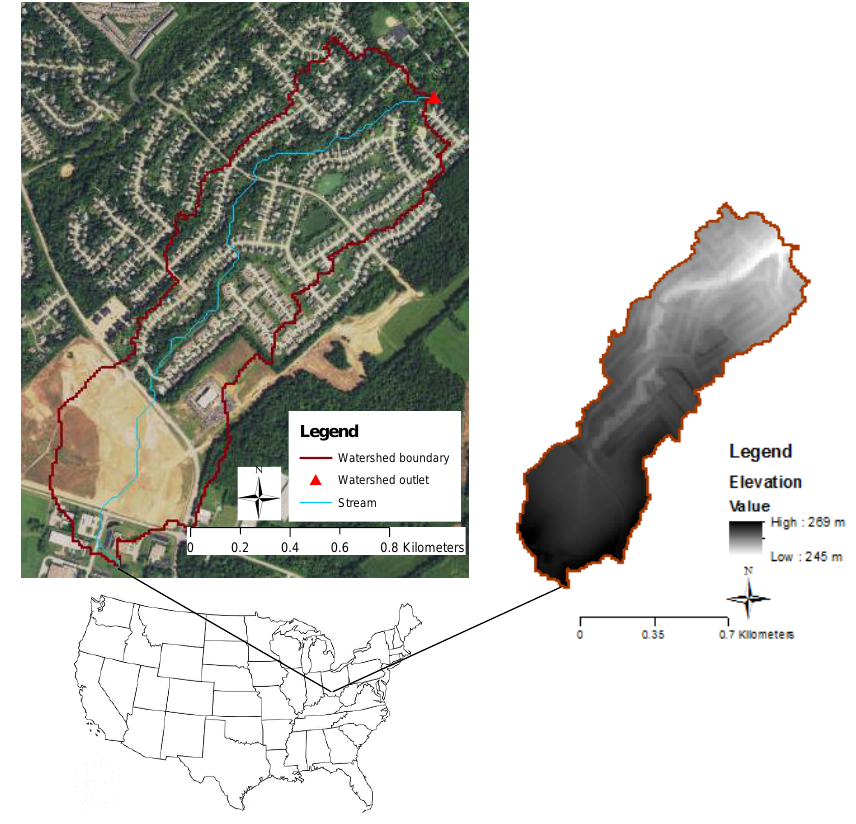
Figure 1. The study area is a 0.92 km 2 subwatershed (Shayler Crossing) of the East Fork Little Miami River watershed, located on the east side of Cincinnati, Ohio in Clermont County, USA. The watershed outlet is identified as a red triangle. Table 1. Summary of Shayler Crossing watershed land use area and